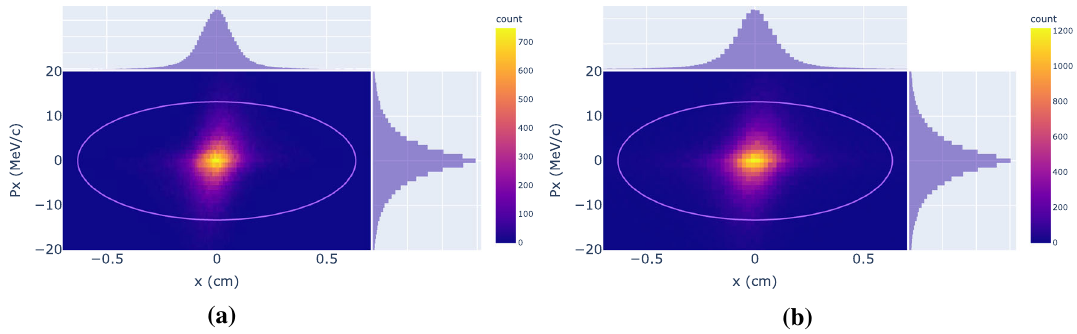
Fig. 10 ( P Z – P t ) Longitudinal-transverse momentum diagram for the positron produced for the conventional scheme ( a ) and hybrid scheme ( b )